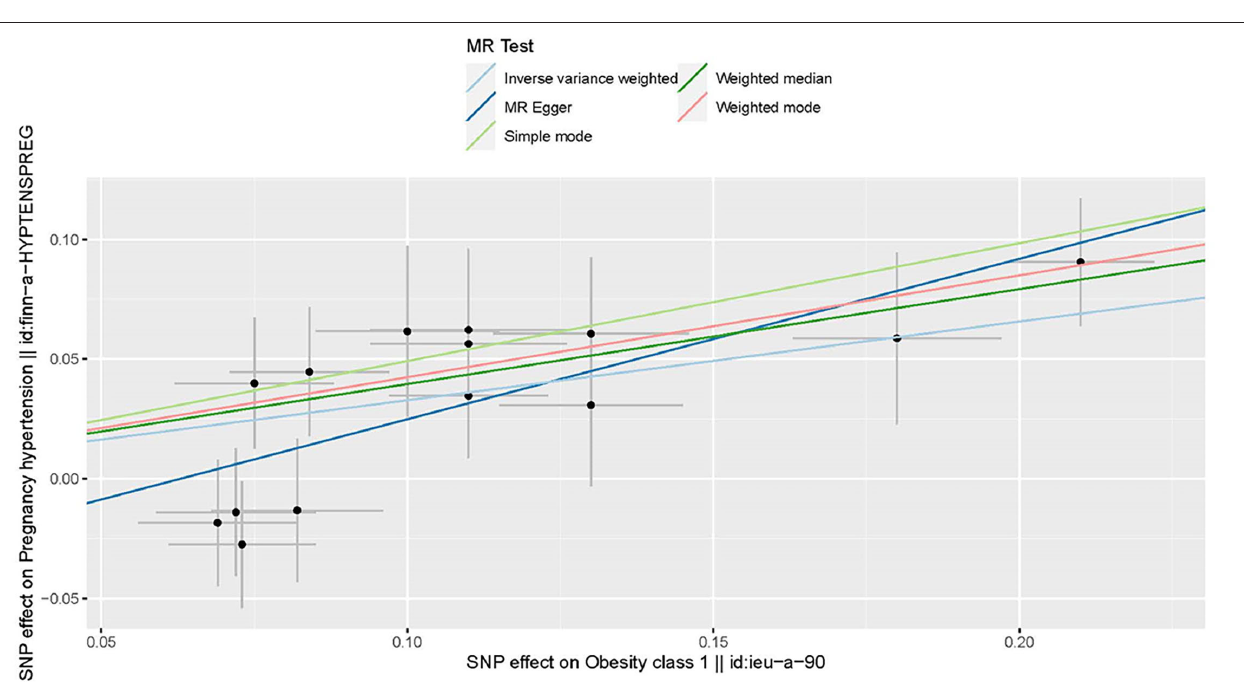
Frontiers in Cardiovascular Medicine |